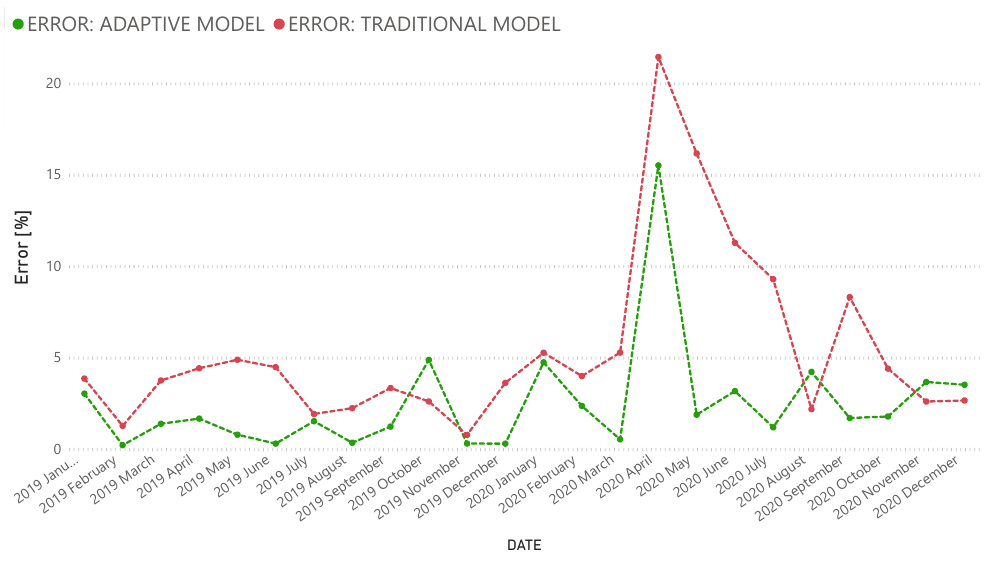
Figure 14. Monthly forecast error for adaptive and traditional